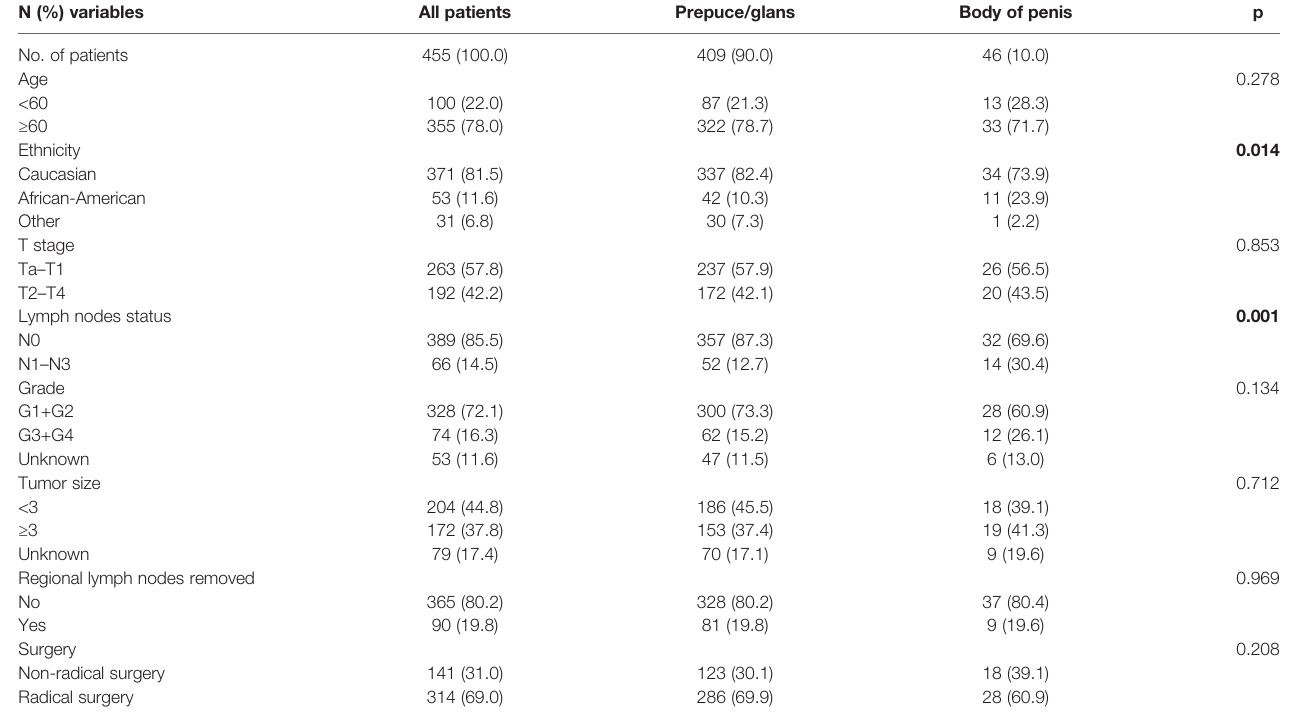
TABLE 1 | Association of tumor location with demographic and clinicopathological characteristics in patients.